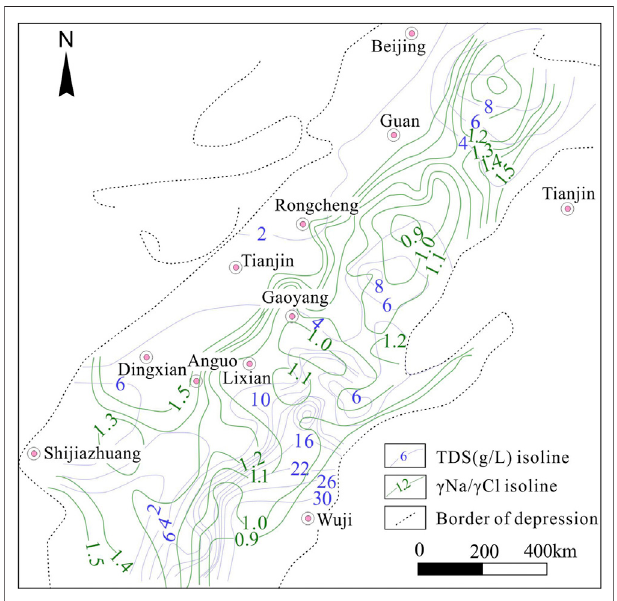
FIGURE 11 | Contour maps of TDS and γ Na/ γ Cl of carbonate geothermal water in the Jizhong depression (according to Yan and Yu,